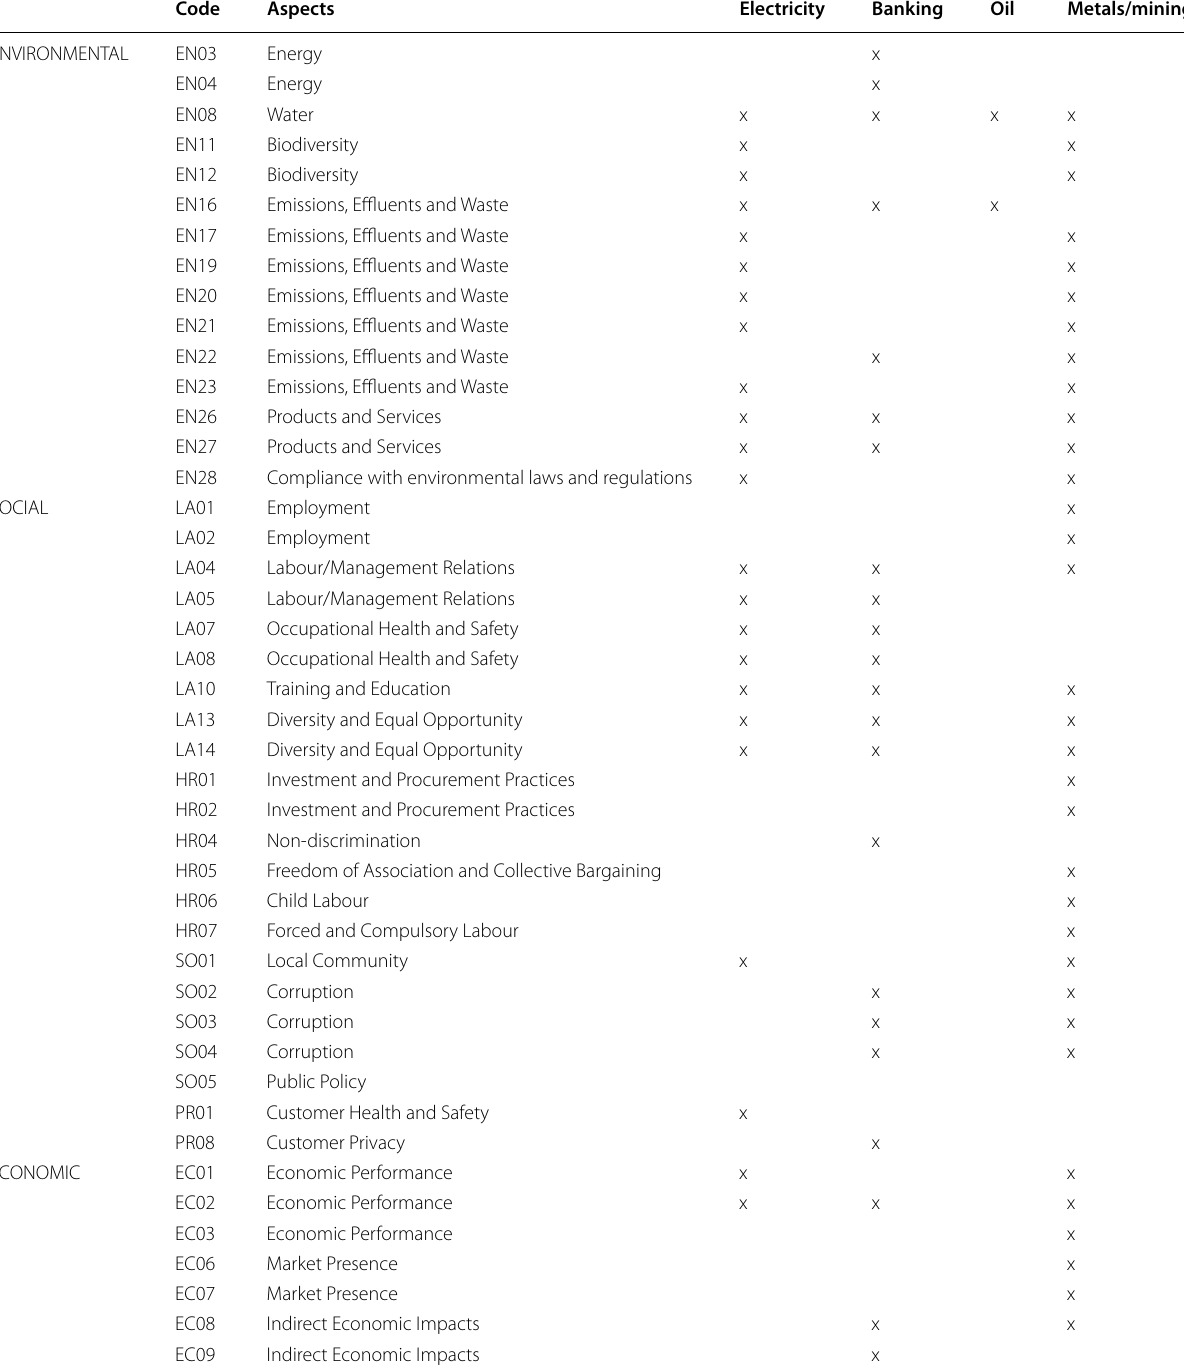
Table 5 Converging performance indicators